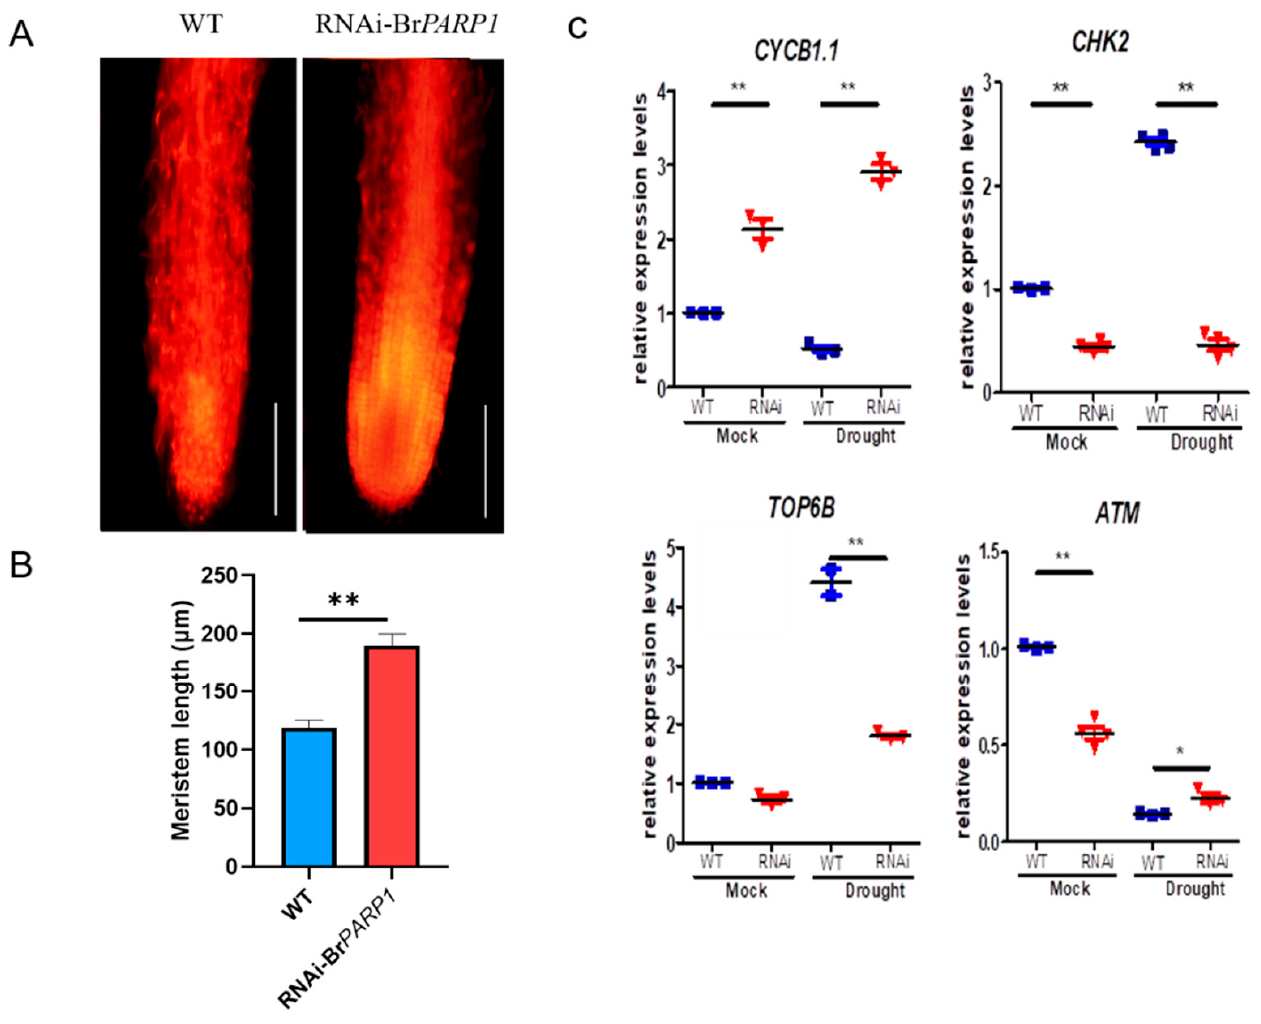
Figure 5. Analysis of Br PARP1 affecting root growth. ( A ) Propidium iodide-stained root meristems of WT and RNAi-Br PARP1 plants. Bar = 100 µ m. ( B ) Principal root meristem length of WT and RNAi-Br PARP1 plants. ( C ) Expression level analysis of root growth transition marker genes.